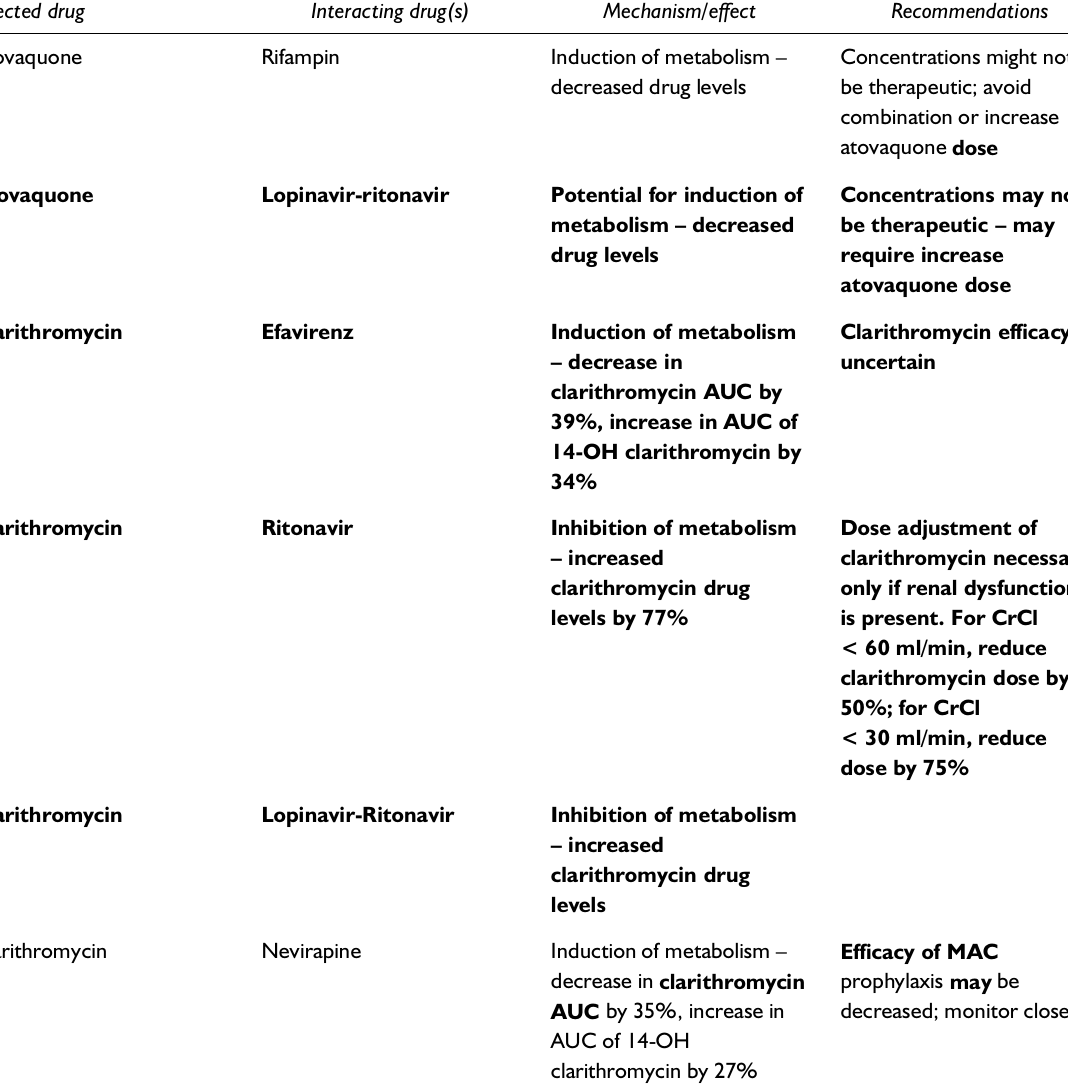
Table 5 Effects of medications on drugs used to prevent opportunistic